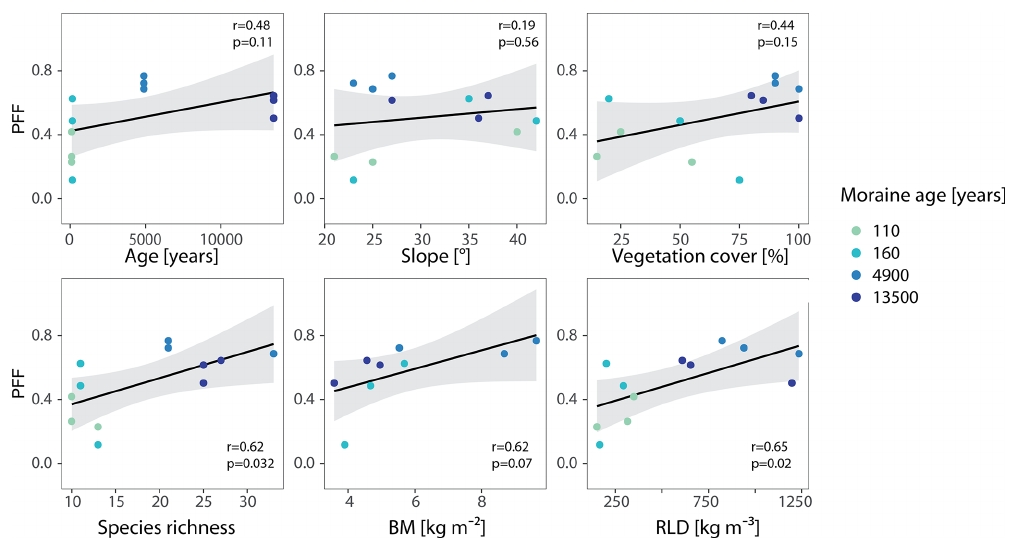
Figure 11. Frequency of preferential flow (PFF) in the upper 20 soil centimeters in relation to moraine age, slope, and vegetation character- istics (BM = above ground biomass, RLD = root length density).